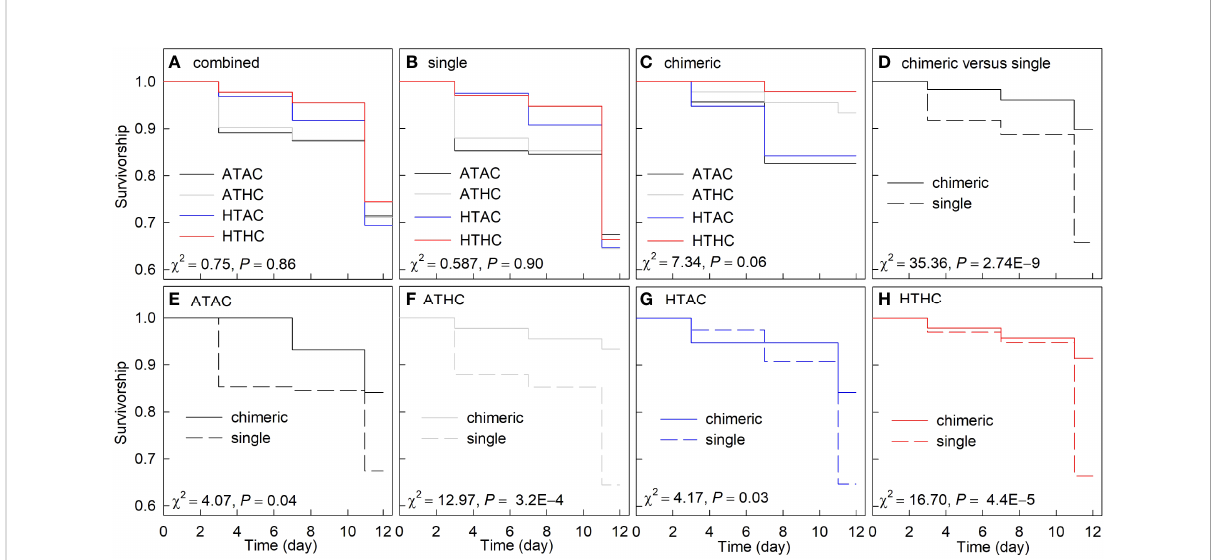
FIGURE 3 Proportional survival curves among treatments in all (A) , (B) single, and (C) chimeric recruits; survival curves of single and chimeric recruits across all treatments (D) and the four respective treatments (E – G) . Experimental treatments: ambient temperature – ambient p CO 2 (ATAC, 28°C- 500 m atm), ambient temperature – high p CO 2 (ATHC, 28°C-1000 m atm), high temperature – ambient p CO 2 (HTAC, 30.5°C-500 m atm) and high temperature – high p CO 2 (HTHC, 30.5°C-1000 m atm). Differences in survival among the treatments were compared using the Kaplan – Meier (K – M) analysis and the statistical results were shown at each